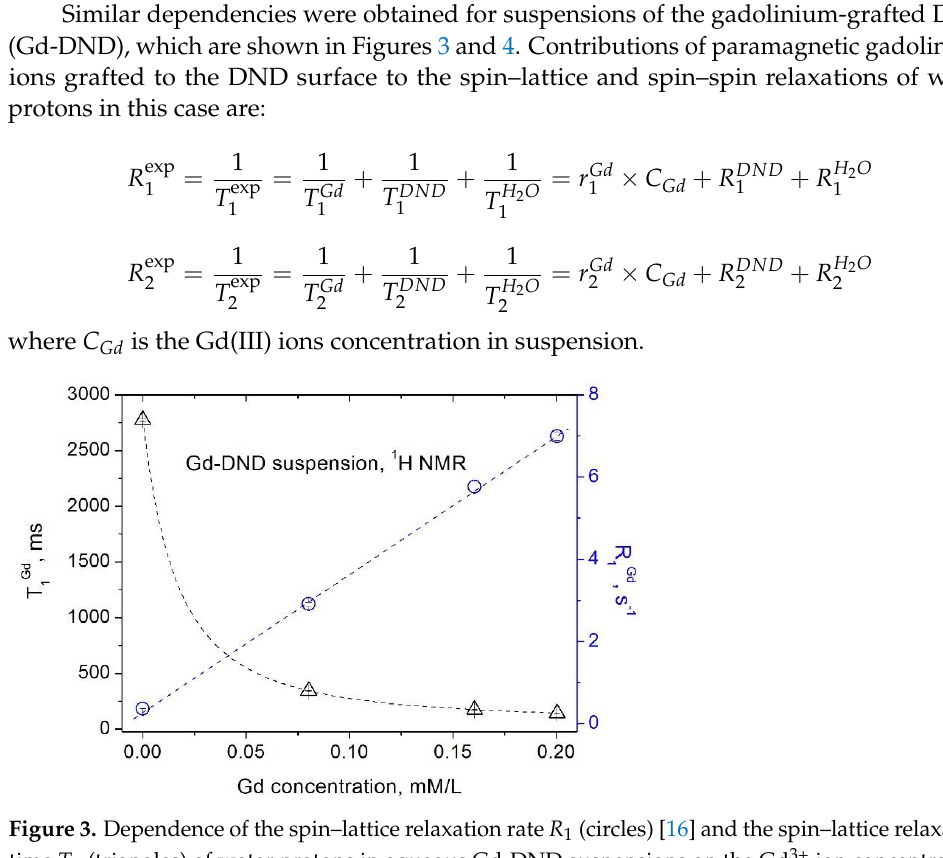
. Figure 4. Dependence of the spin – spin relaxation rate R 2 (circles) [16] and the spin – spin relaxation time T 2 (triangles) of water protons in aqueous Gd-DND suspensions on the Gd 3+ ion concentration. Therefore, the proton spin – lattice and spin – spin relaxation times reveal a hyperbolic dependence on Gd C :